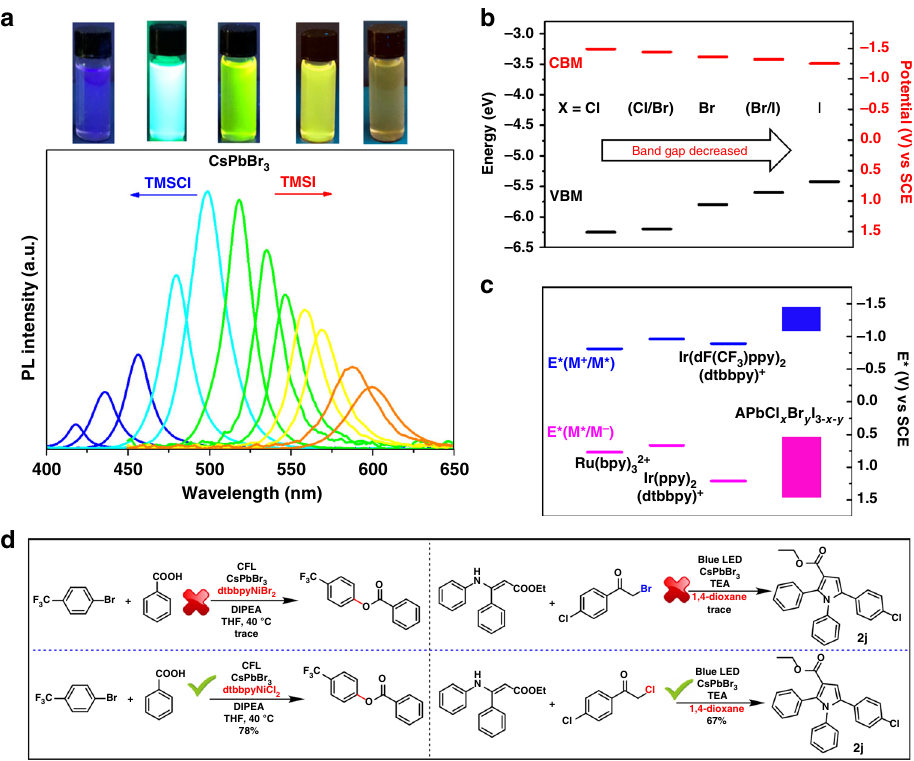
Fig. 5 Band-tuning of perovskite. a The PL spectra of colloidal CsPbBr 3 in dichloromethane via band tuning with trimethylsilyl chloride or iodide and their representative images under UV lamp (top). b Bandedges of APbCl x Br y I 3- x - y . c Excited-state potential ( E* ) range of APbCl x Br y I 3- x - y comparing with noble transition-metal catalysts. d Two successful reaction examples with perovskite band-tuning. Source data are provided as a Source Data fi